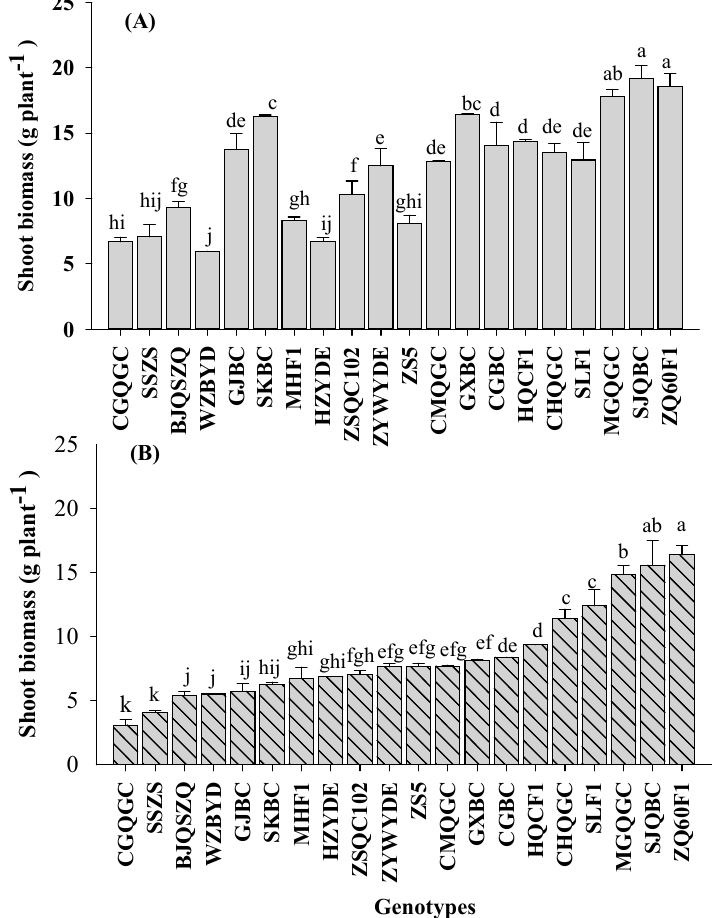
Figure 1. Shoot biomasses of 20 pakchoi genotypes grown at low- ( A ) and high- ( B ) levels of Cd and As co-contaminated soils. Error bars depict standard errors of the means ( n = 3). Different letters indicate significant difference among genotypes according to LSD test ( p < 0.05).